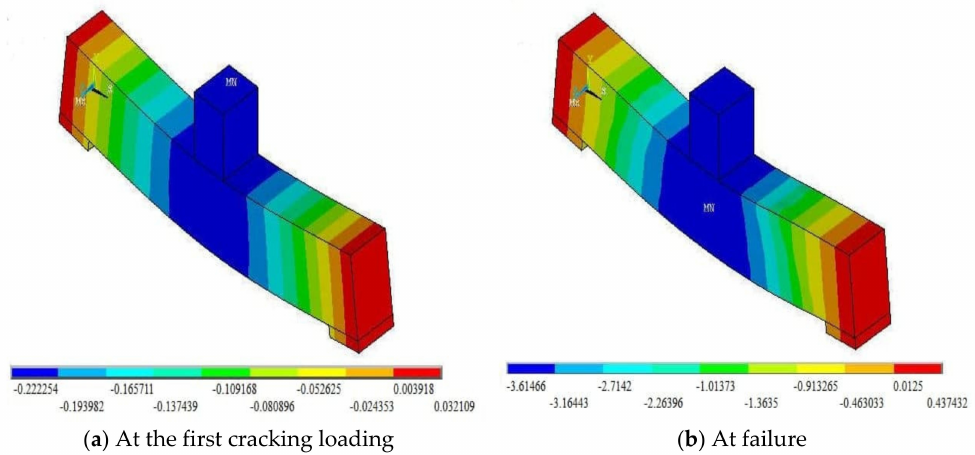
Figure 10. 3D deflection contours of beam model B2 at different loading stages.